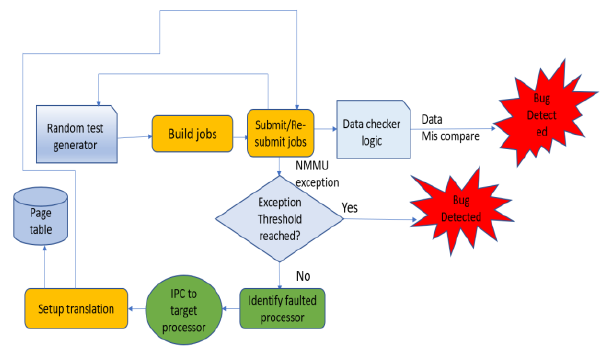
Figure 3. Proposed validation methodology